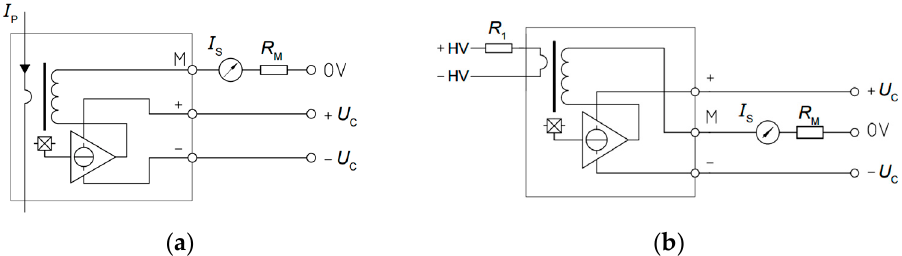
Figure 4. Hall effect transducers schematic: ( a ) LA 55P/SP1 current transducer; ( b ) LV 25-P voltage transducer.